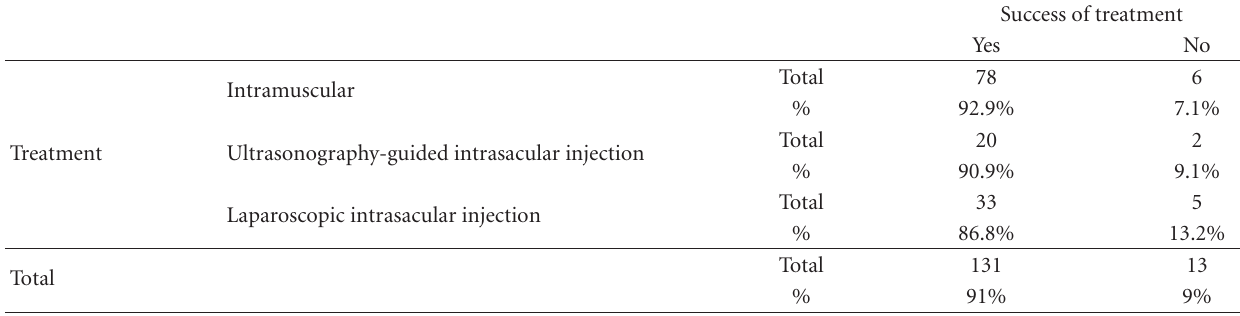
Table 1: E ff ectiveness of the di ff erent medical treatment modalities. Results are expressed as frequencies and percentage ( P = 0 . 562).